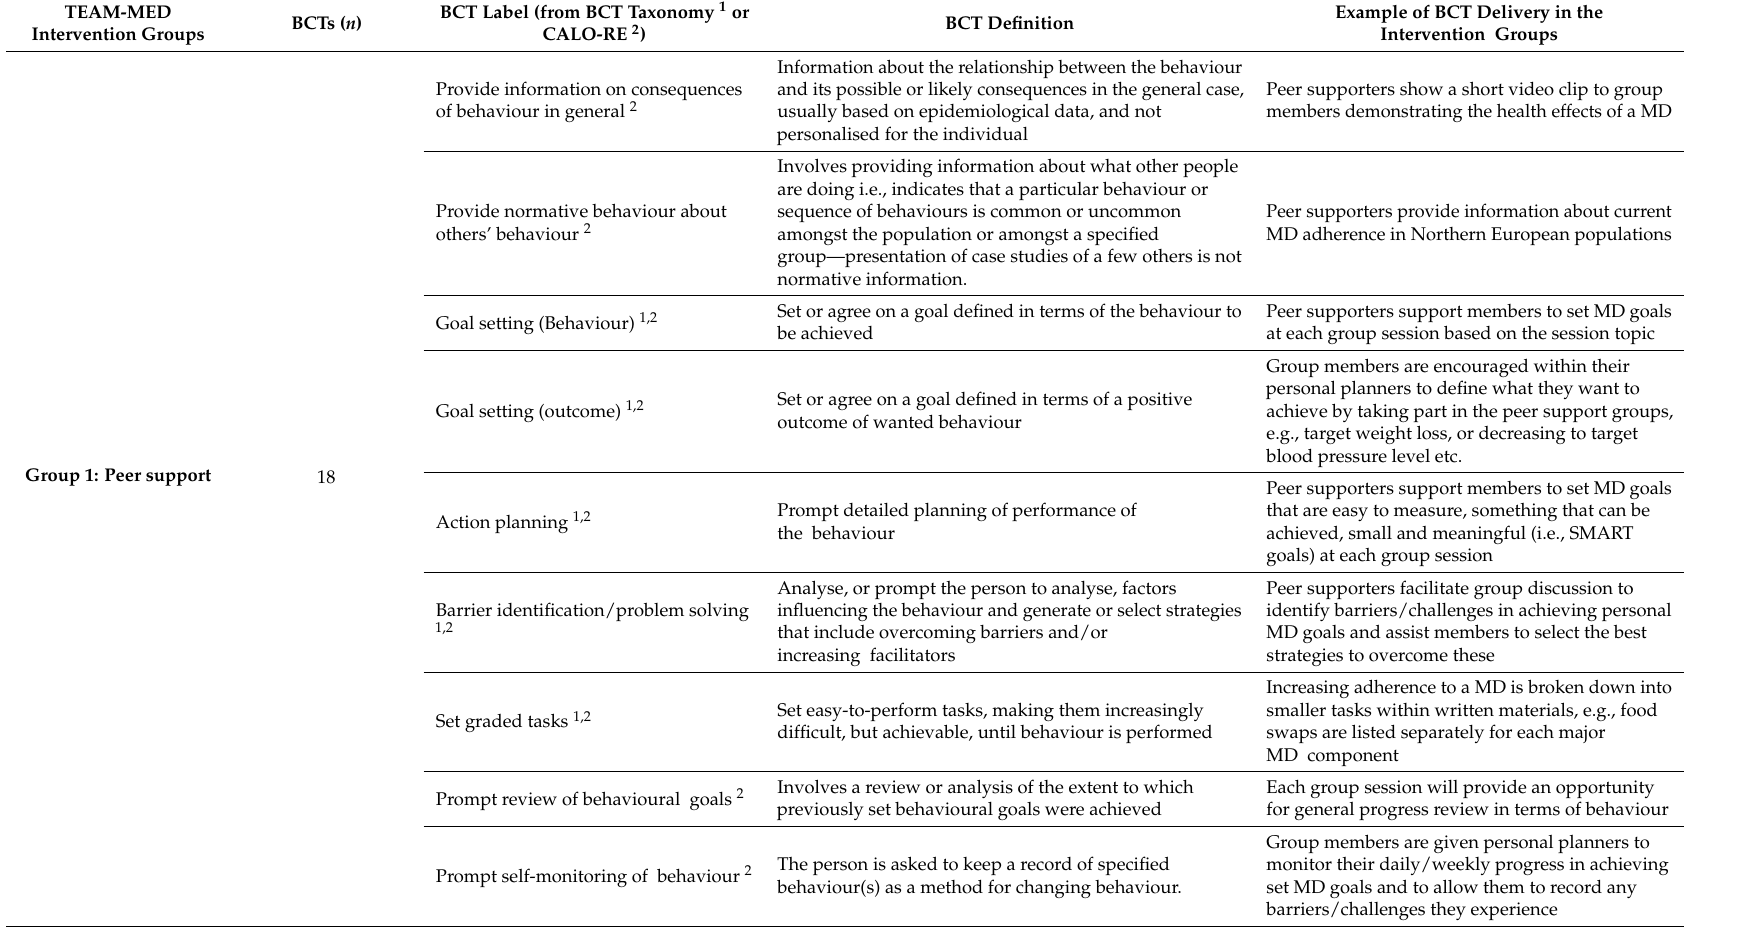
Table 1. Behaviour Change Techniques used to encourage dietary change towards a Mediterranean